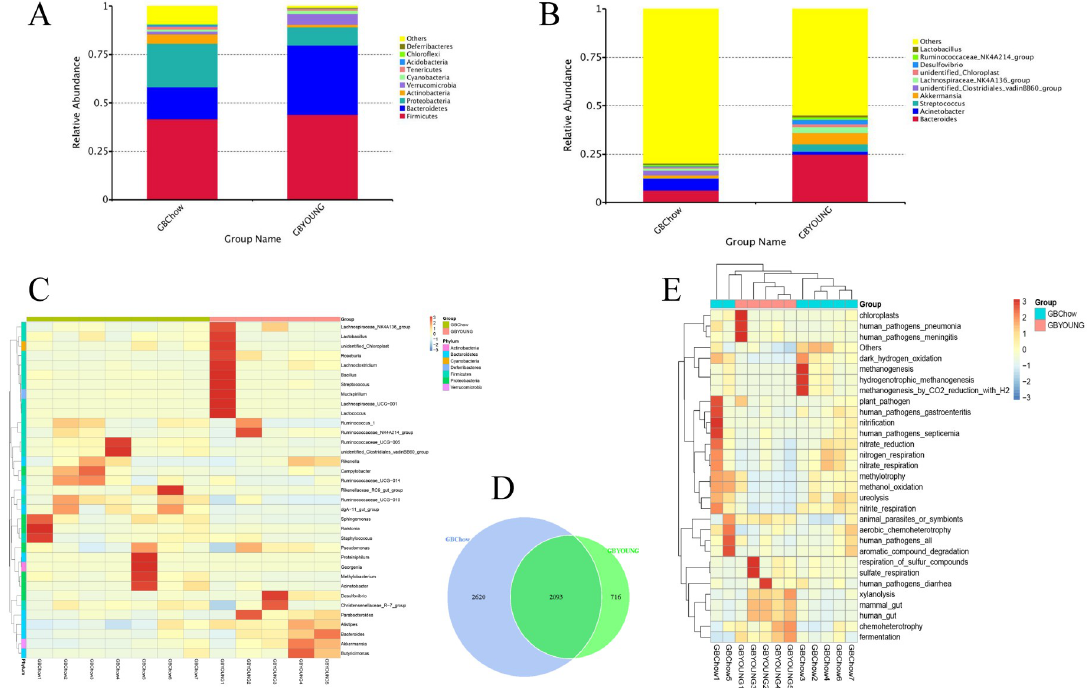
Fig 2. Profiles of gallbladder microbes in rabbits of the 2 age groups. A: Phyla level comparisons of the microbial components. B: Genera level comparisons of microbial components. C: Heat map of hierarchy cluster results for the abundance of genus. D: Venn diagram described the number of features that are distinct and shared across the young and adult rabbits. E: Functional analysis of the microbes used by FAPROTAX. GBChow: adult healthy rabbits; GBYOUNG: healthy rabbits before weaning.